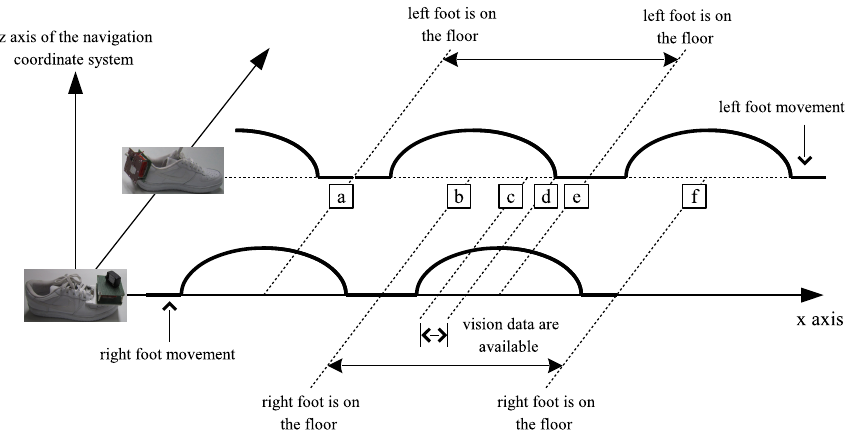
Figure 5. Typical two feet movement in the navigation coordinate